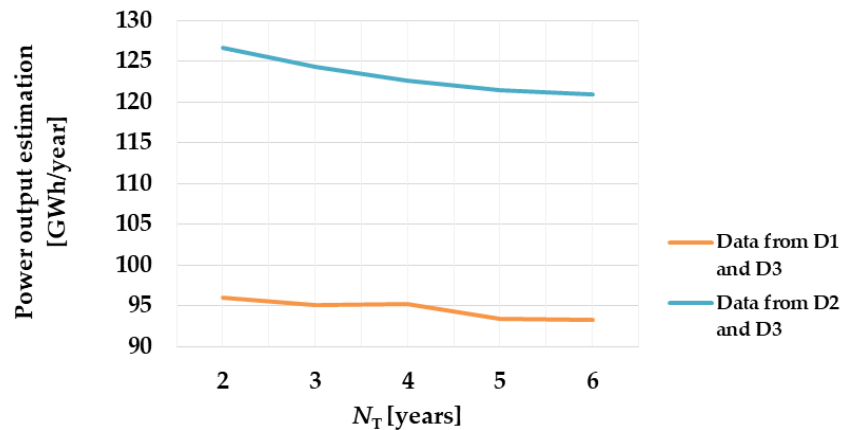
Figure 6. Wind farm power output estimation according to different N T .